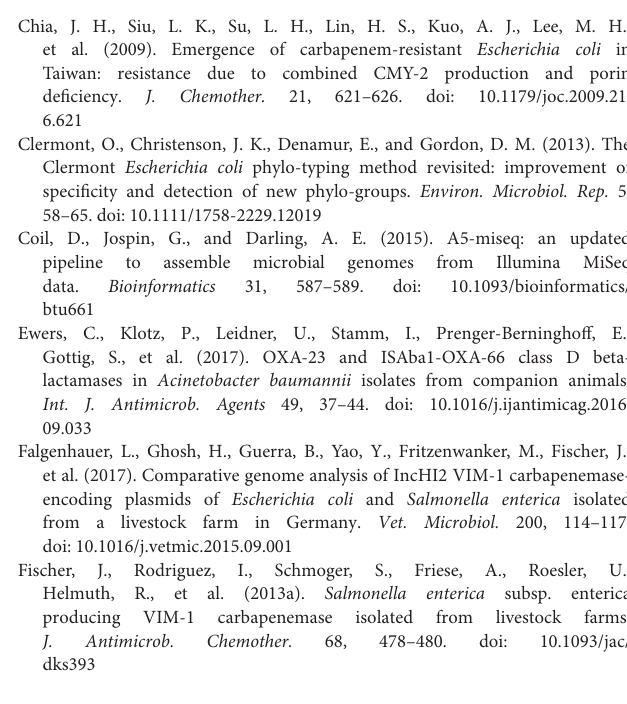
Supplementary Figure 1 | (A) Sequence alignment of the incRNAI of IncB (I), IncK2-pDV45 (II) and pG-268-2 (III). The IncB incRNAI reference sequence derived from Siemering et al. (1993), the IncK2-pDV45 incRNAI reference sequence from Seiffert et al. (2017). (B) Predicted RNA folding of the incRNAI of IncB (I), IncK2-pDV45 (II) and pG-268-2 (III) by RNAfold web server. Supplementary Figure 2 | Results of the Blue-Carba assay obtained from E. coli Isolate G-268-2. Beside the wildtype strain also its transformants containing the IncB/O/K/Z-plasmid ( bla CMY - 2 ) and the IncX4-plasmid ( mcr-1 ) were tested. As positive control (PC) the bla VIM - 1 containing isolate R178 was used. NTC, no template